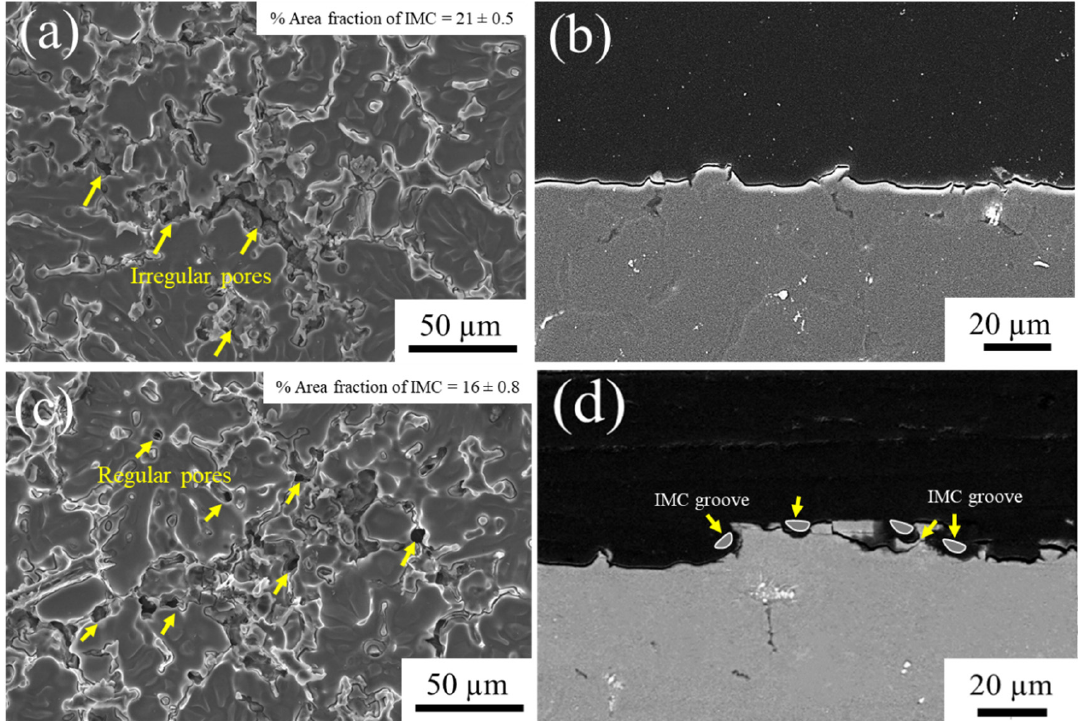
Figure 3. SEM micrographs of the A535 substrate surface ( a , c ) and cross-section surface ( b , d ) after alkaline etching for ( a , b ) 2 min and ( c , d ) 4 min.